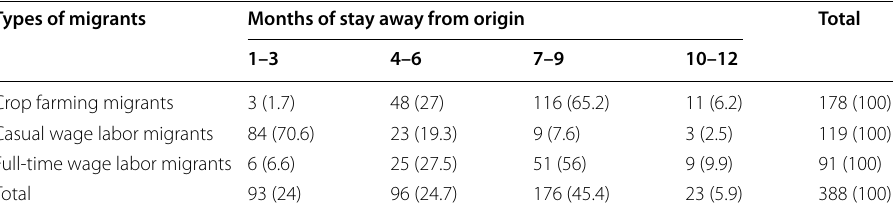
Table 4 Months of stay away from the place of origin across types of migrants. Source : Own Household Survey